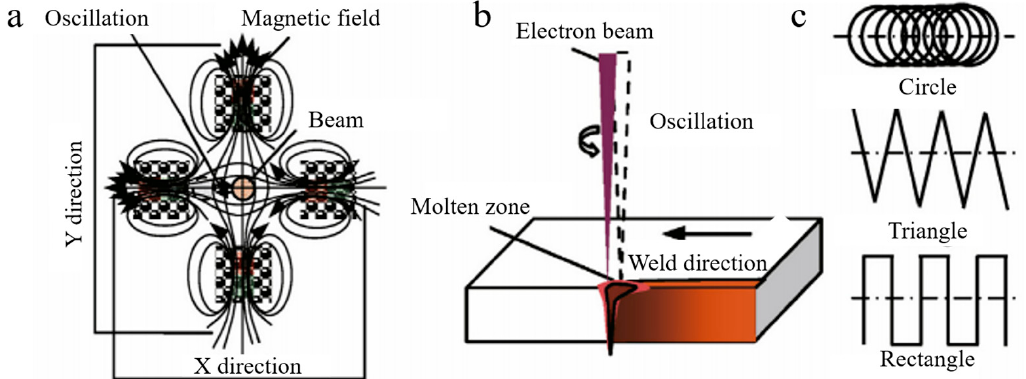
Figure 4. Sketch of EBW with beam oscillation [27]. ( a ) Oscillation with electromagnetic fields, ( b ) beam oscillating welding, ( c ) wave function. Reprinted with permission from [27], 2014, Elsevier.